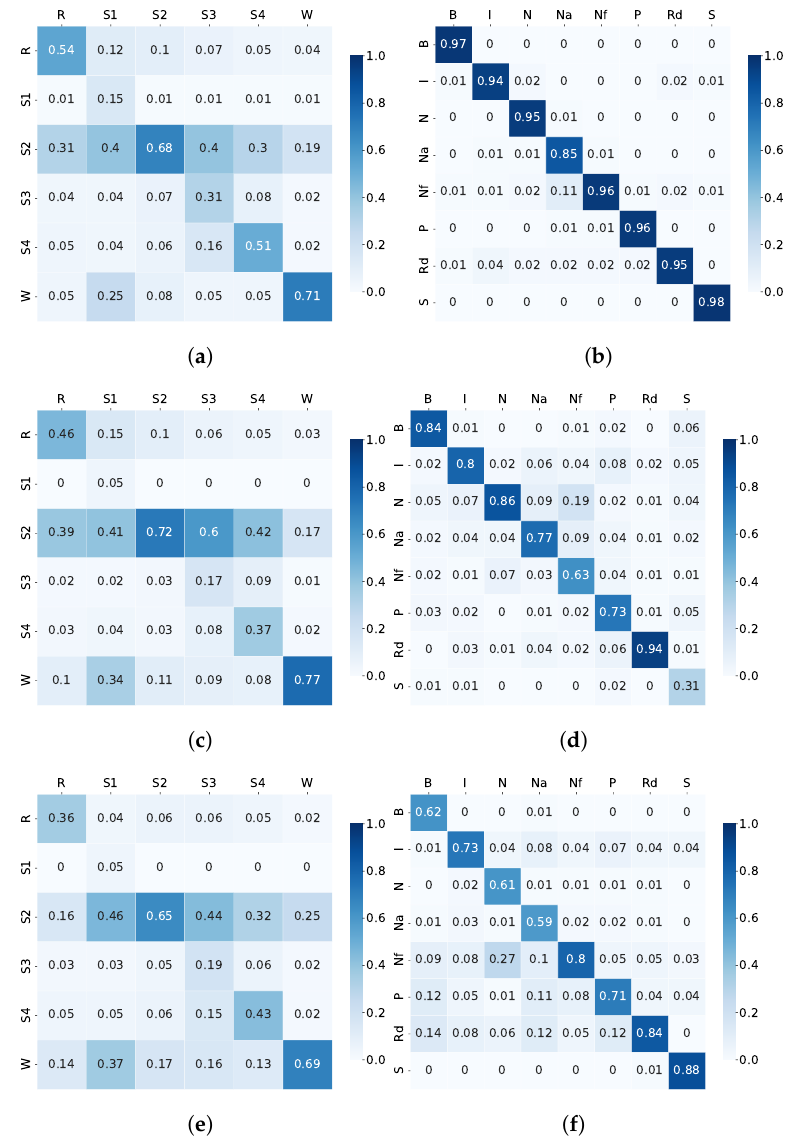
Figure 5. Experiment 1: Examples of confusion matrices for sleep stage and sleep disorder detection using baseline single-modality CNN classifiers: ( a ) ECG Sleep Stage detection confusion matrices; ( b ) ECG Sleep Disorder detection confusion matrices; ( c ) EEG Sleep Stage detection confusion matrices; ( d ) EEG Sleep Disorder detection confusion matrices; ( e ) EMG Sleep Stage detection confusion matrices; ( f ) EMG Sleep Disorder detection confusion